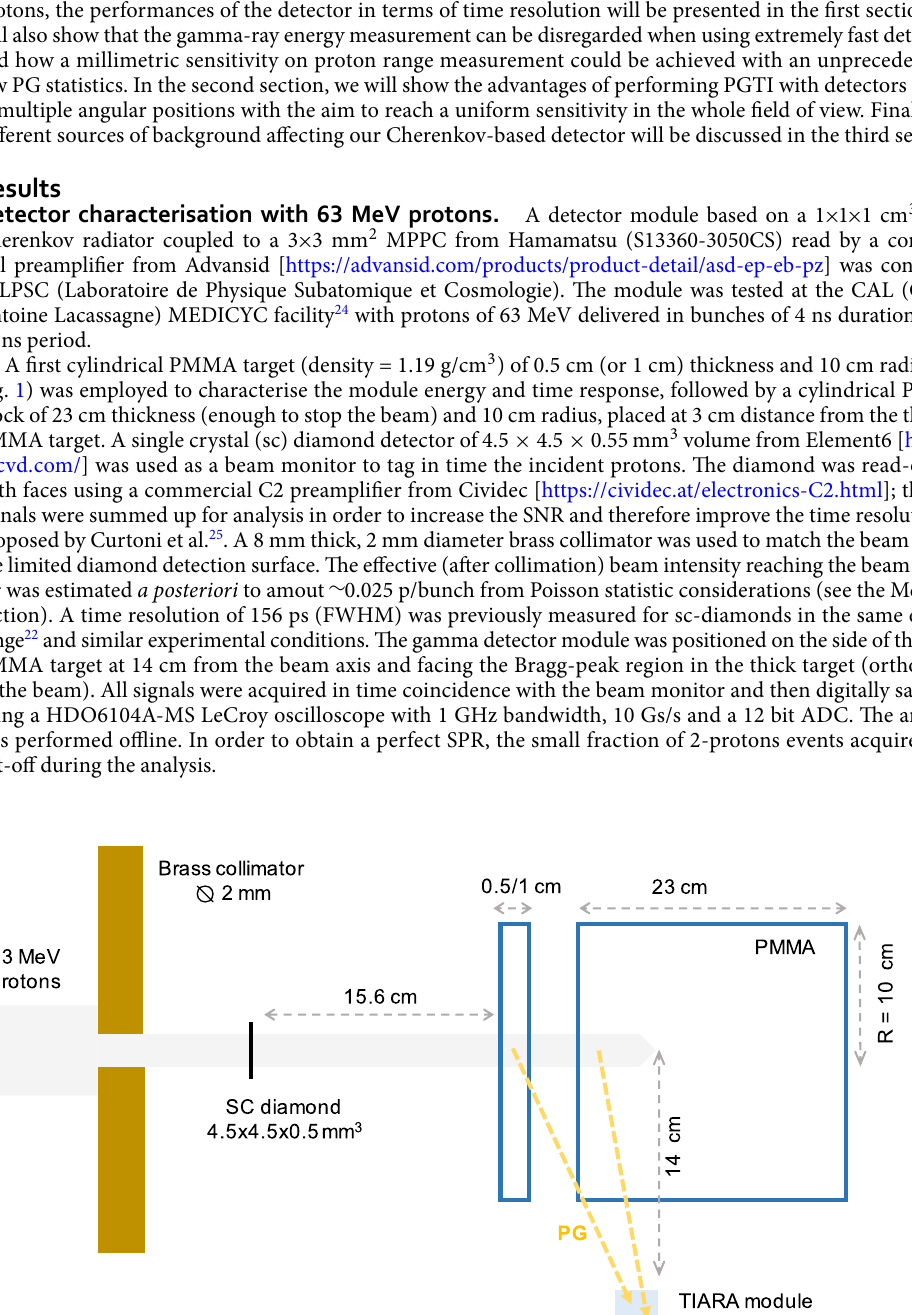
3 mm 2 SiPM and facing the Bragg peak × 4.5 0.55 mm 3 volume. For × ×